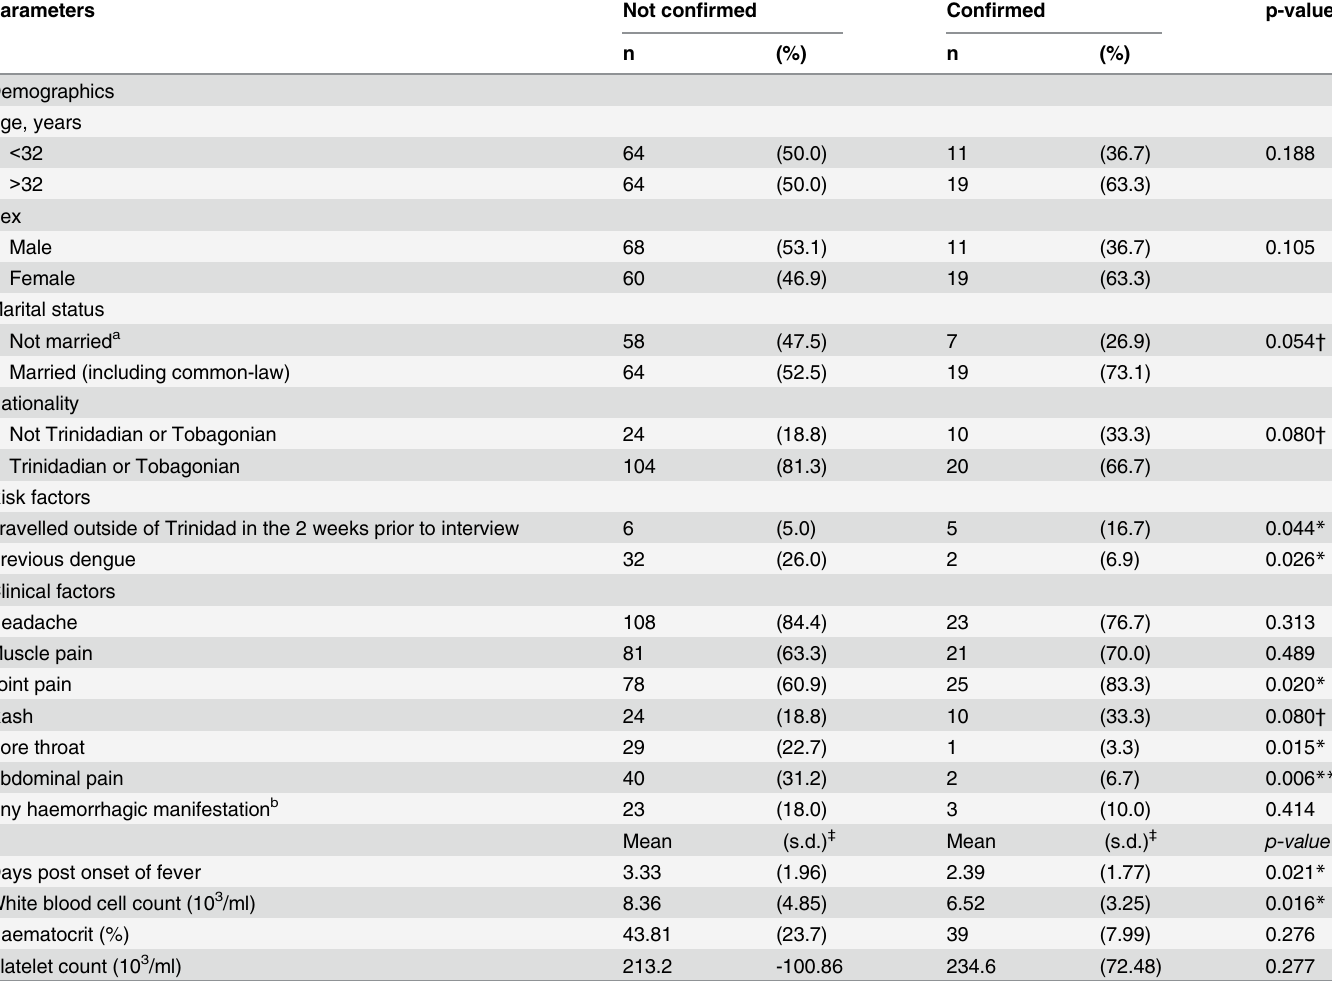
Table 1. Bivariable associations between select characteristics of patients of the APCF of the EWMSC, T&T (Dec 2013 – Nov 2014) and having a confirmed infection l= with CHIKV.